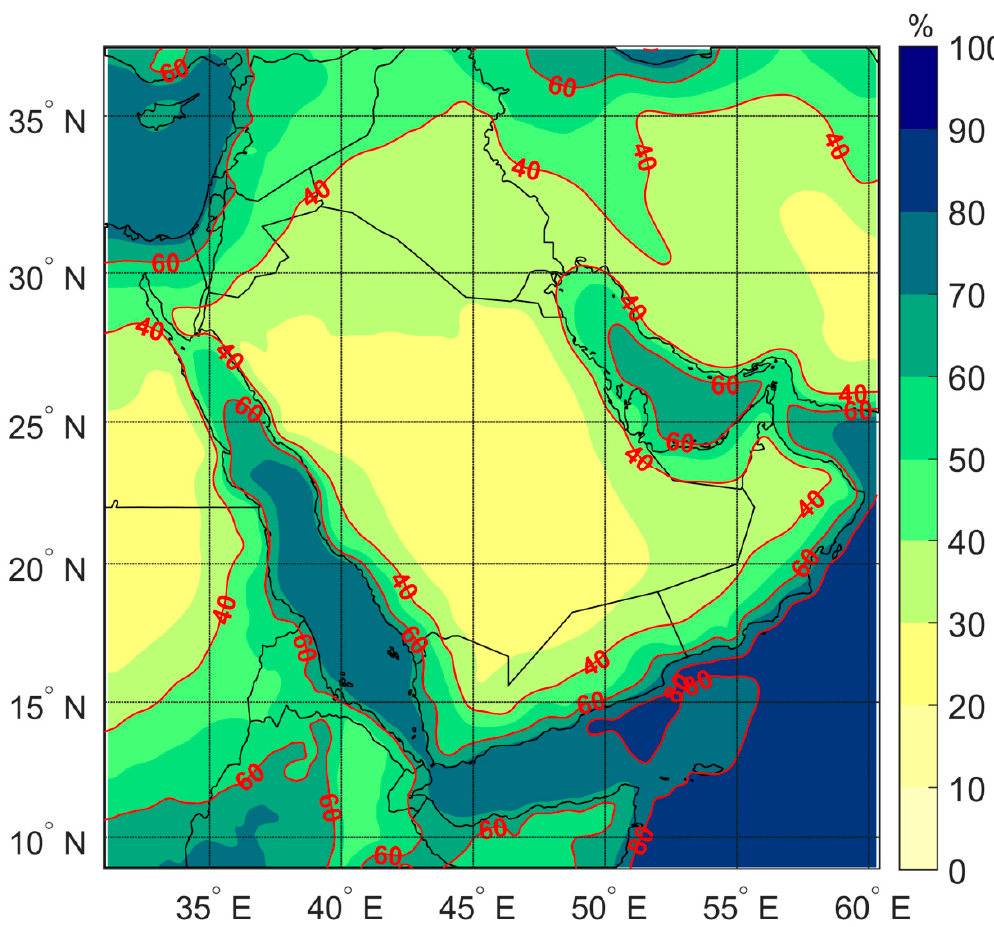
Figure 10. Annual distribution of mean relative humidity for the period 1986–2015.